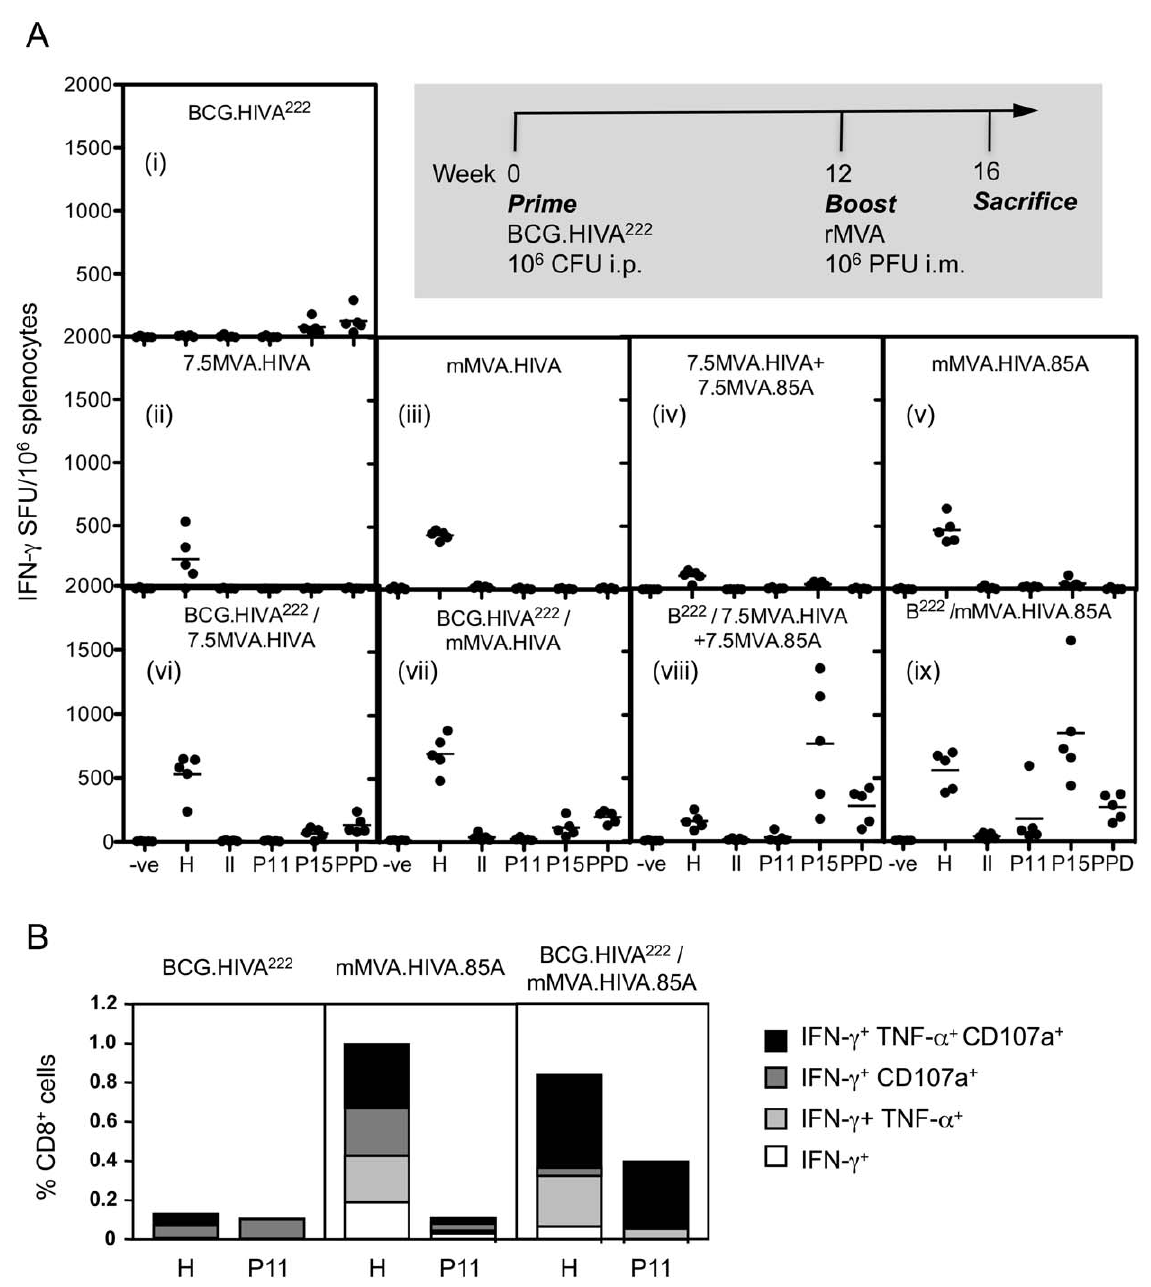
Figure 4. Induction of robust HIV-1- and M.tuberculosis -specific T cells by the BCG.HIVA 222 prime - mMVA.HIVA.85A boost regimen. ( A ) Groups of 5 BALB/c mice received either BCG.HIVA 222 (B 222 ) ( i and vii–ix ) or no vaccine ( ii–v ) on week 0, followed by rMVA(s) ( ii–ix ) as indicated on the top of the graphs or no vaccine ( i ) at week 12. On week 16, mice were killed and their HIV-1 (H and II)- and mycobacterium (P11, P15 or PPD)- specific responses were determined in an IFN- c ELISPOT assay using MHC class I (H and P11) or class II (II and P15)-restricted peptides. Results are shown as individual animal responses (black dots) with group means (horizontal bars). ( B ) The functionality of vaccine-induced CD8 + T cell responses was assess in a multicolour intracellular cytokine staining assay. The group mean frequencies of single-, double- or triple-cytokine-producing H- or P11-specific cells following background subtraction are shown for the three regimens indicated above the graphs.